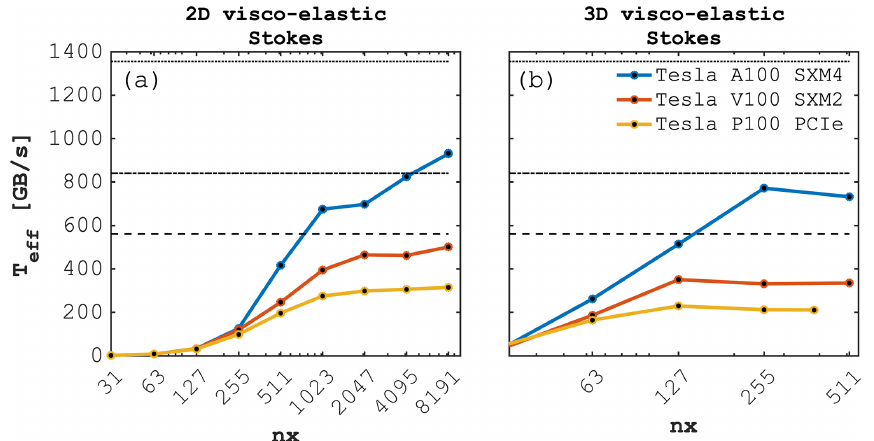
Figure 10. Effective memory throughput T eff [GBs − 1 ] for the (a) 2D and (b) 3D the visco-elastic Stokes flow Julia GPU implementations using ParallelStencil.jl executed on various NvidiaGPUs (Tesla A100 SXM4, Tesla V100 SXM2 and P100 PCIe). The dashed lines report the measured peak memory throughput T peak (1355GBs − 1 Tesla A100, 840GBs − 1 Tesla V100, 561GBs − 1 Tesla P100) one can achieve on a specific GPU architecture, which is a theoretical upper bound of T eff